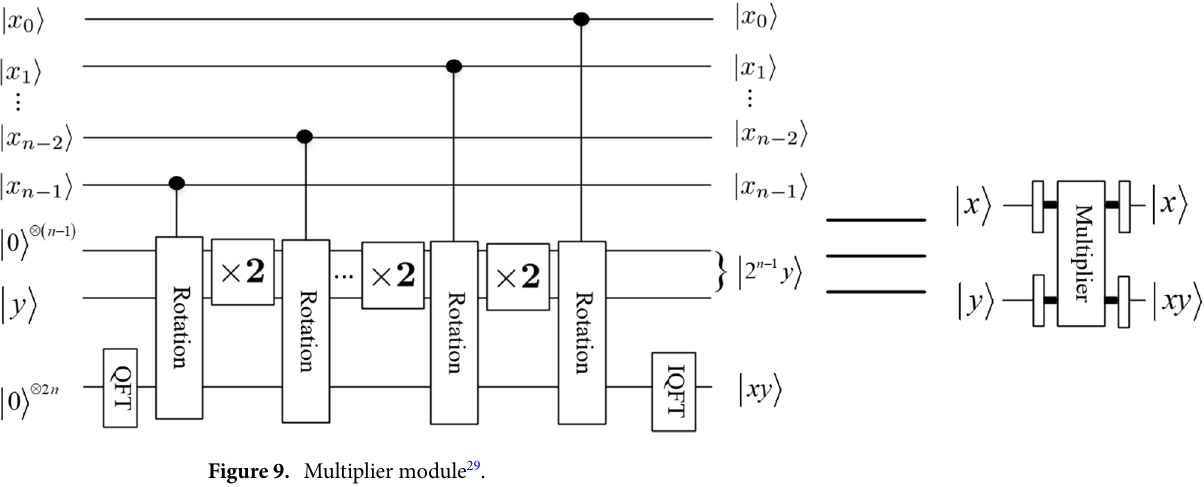
Figure 8. Subtractor module 29 .